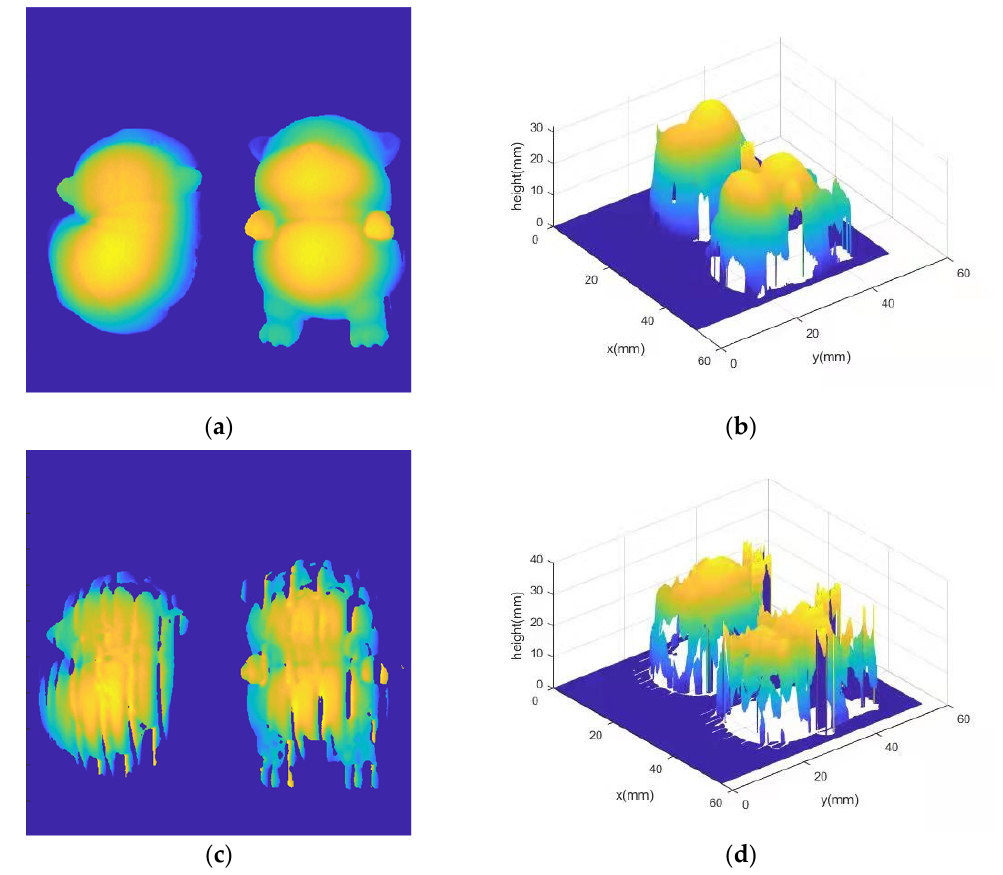
Figure 7. The reconstructed results. ( a,b ) The result obtained by the proposed method; ( c , d ) the reconstructed result with the traditional PSP. reconstructed result with the traditional